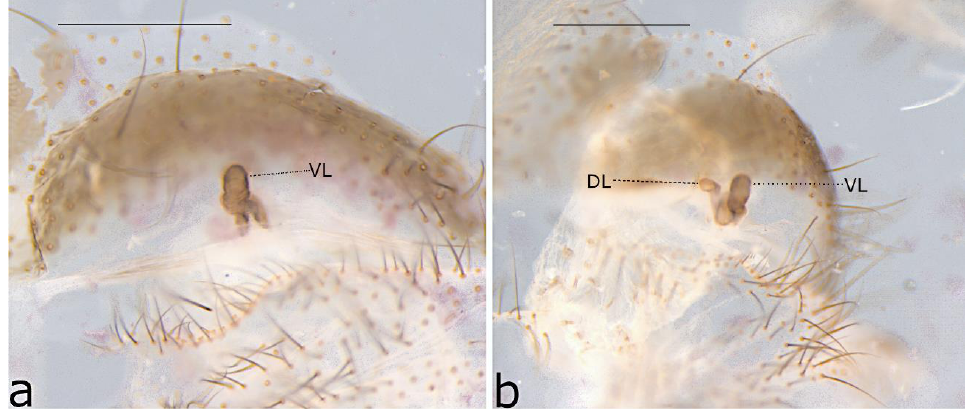
Figure 25. Ariadna umbra sp. nov. ♀ paratype (SAMA NN30622) from Naracoorte (SA): anterior re- ceptaculum ( a ) ventral view; ( b ) same, lateral view. Scale bar = 0.5 mm. DL = dorsal lobe, VL = ventral lobe.